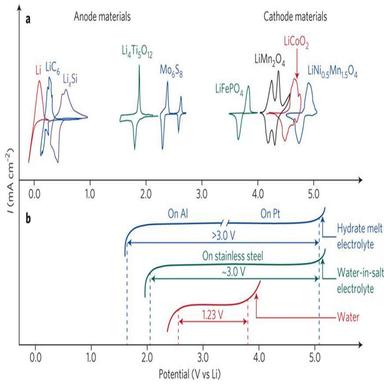
(a) Typical redox potentials (vs. Li+/Li) of several common anode and cathode materials used in commercial LIBs. (b) The variation of the electrochemical stability window of aqueous electrolytes at pH 7 with different salt concentrations. Distinctions in pure water, 21 m LiTFSI WiSE, and 27.8 m Li(TFSI)0.7(BETI)0.3 (hydrate melt) electrolytes. Reproduced with permission from Springer Nature.